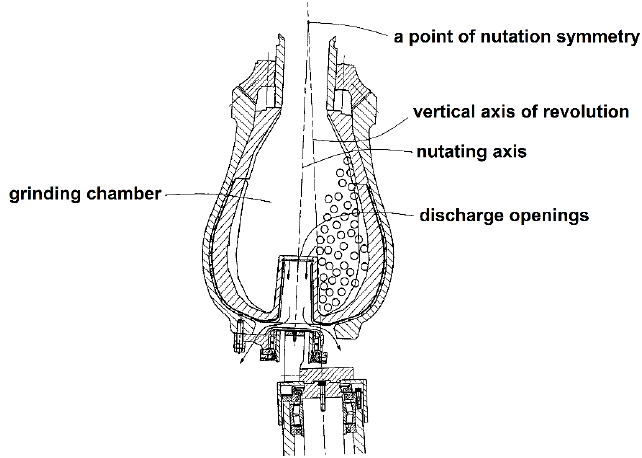
Figure 7. Schematic of a centrifugal nutation mill. Modified from Hoyer DI, Hills P. Centrifugal grinding mills. Patent US 7,070,134 B1, 2006.